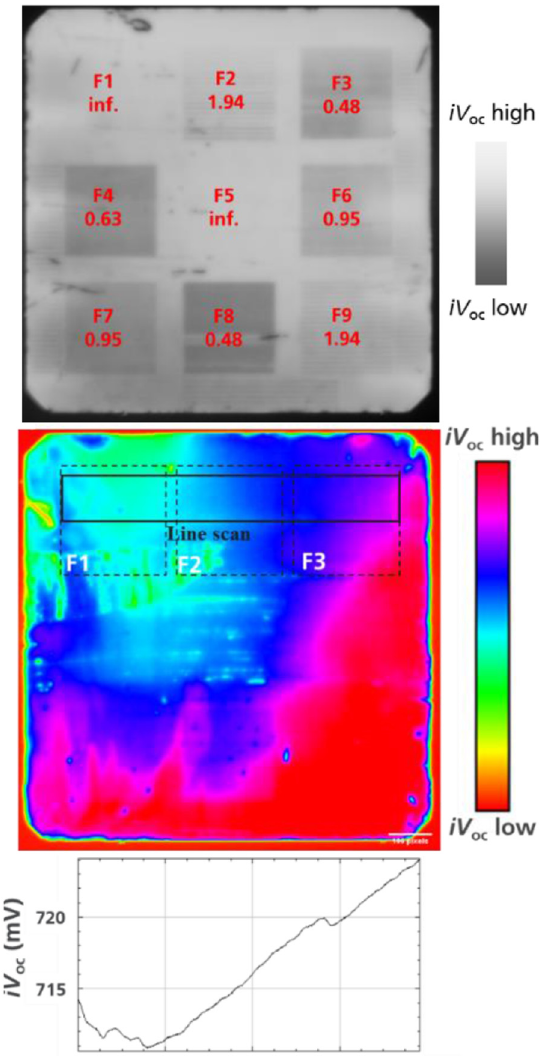
Fig. 1. TOP: A PL image of a over fi red wafer, indicating nine individual fi elds F1-F9 with varying Finger pitches in “ mm ” . On the edges TLM structures are located. Middle: An implied iV oc Mod-PL image of a selected sample showing no fi eld pattern, but other signi fi cant inhomogeneities. The iV oc as a result from the indicated line scan area is shown in the bottom